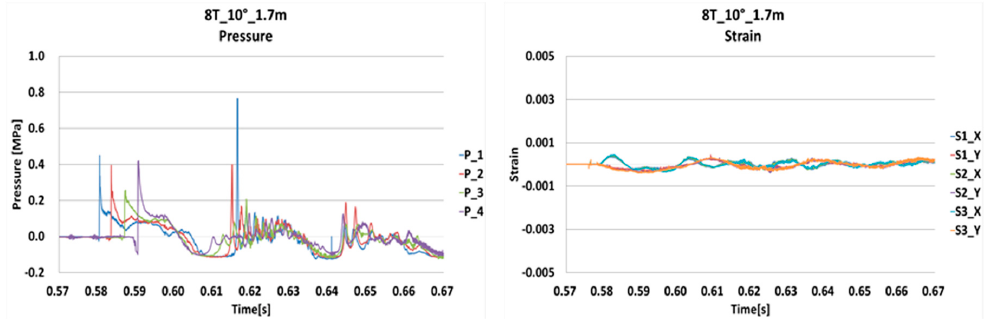
Figure 10. History of pressure and strain in the model with deadrise angle of 10° (Drop height: 1.7 m). Figures 11 and 12 show that the strain history does not converge to zero, when the impact was applied and deformation occurs, the second peak due to the elastic e ff ect was confirmed to be larger or similar to the first peak.